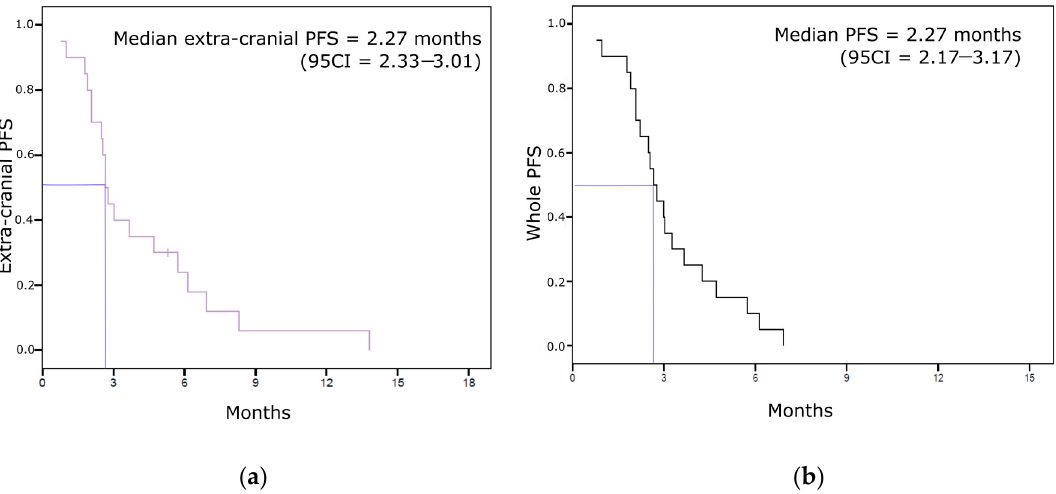
Figure 2. Non-CNS PFS Kaplan–Meier curves. ( a ) Extra-cranial progression-free survival. ( b ) Whole progression-free